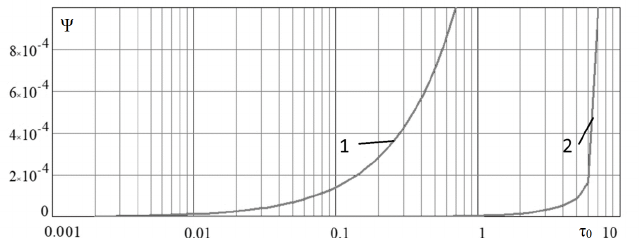
Figure 7. The function of the approximation error of numerical solutions of the test problem II based on the scheme (30) depending on the time step: 1—explicit scheme ( σ = 0), 2—scheme with weight σ =